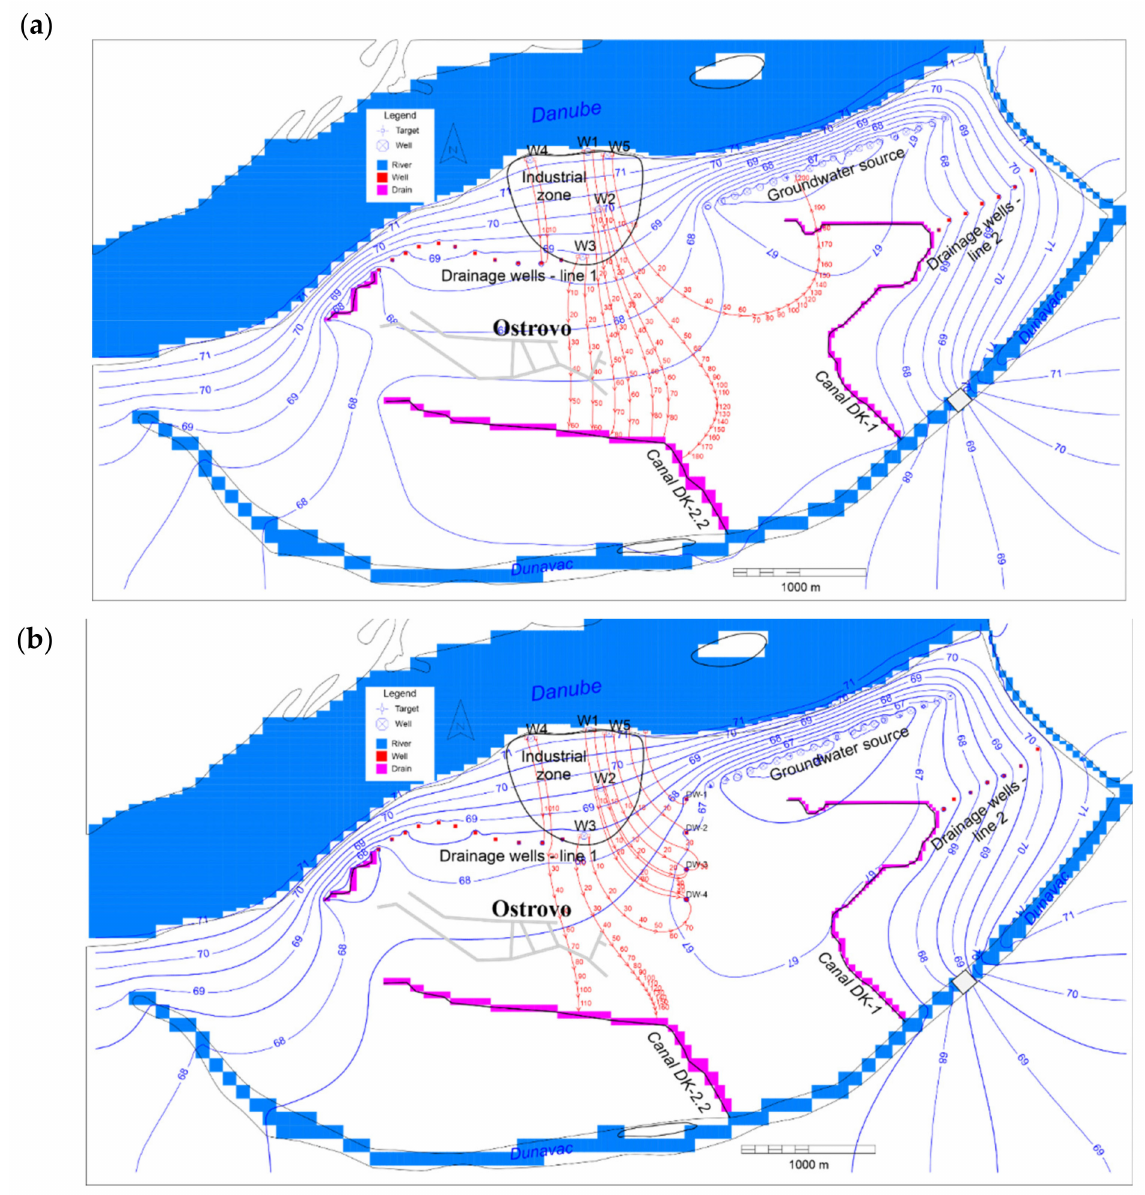
Figure 12. Hydroisohypses and recharge zone at ( a ) high and ( b ) low stages of the Danube in 2015 (second model